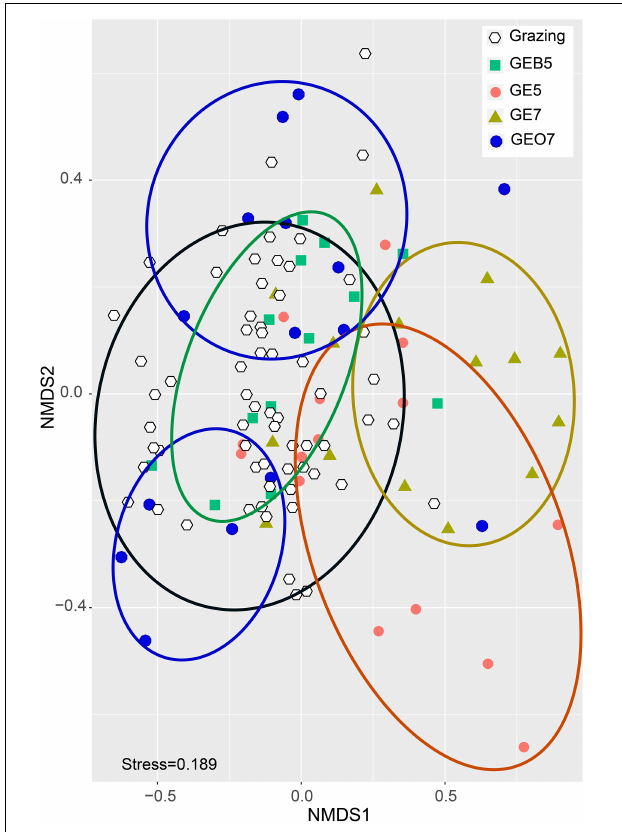
FIGURE 3 | A non-metric multidimensional scaling (NMDS) ordination of the investigation quadrats. GEO7, GE7, GE5, and GEB5 represent grazing exclusion over 7 years, 7 years, 5 years, and below 5 years, respectively. Grazing represents continuous grazing in the central